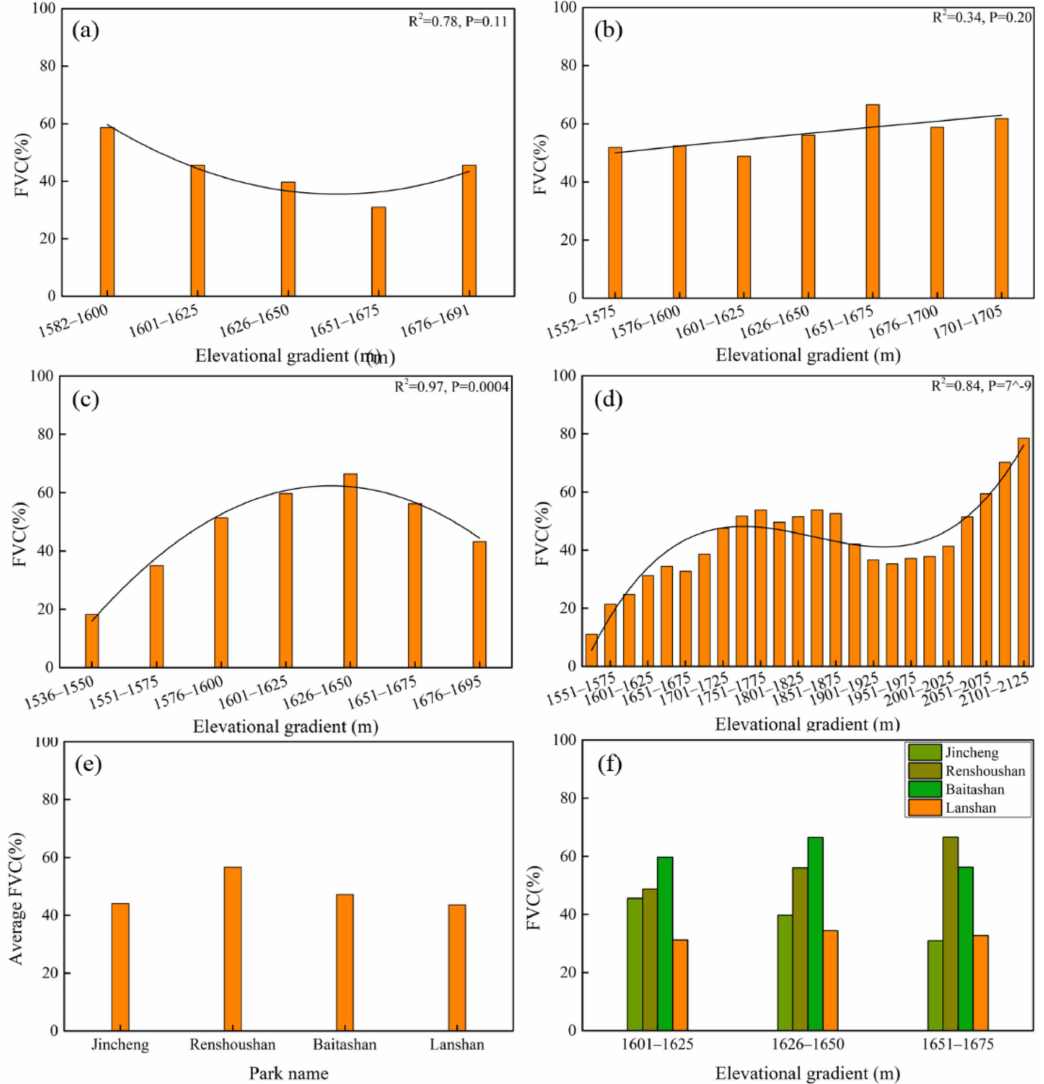
Figure 3. Variation of FVC by altitude, average FVC, and comparison of FVC at the same elevational grdients in the four parks. ( a ) Jincheng Park; ( b ) Renshoushan Park; ( c ) Baitashan Park ( d ) Lanshan Park; ( e ) average FVC; and ( f ) comparison of FVC at the same elevational gradients among the four parks. 3.2. Plant Species Diversity Change across